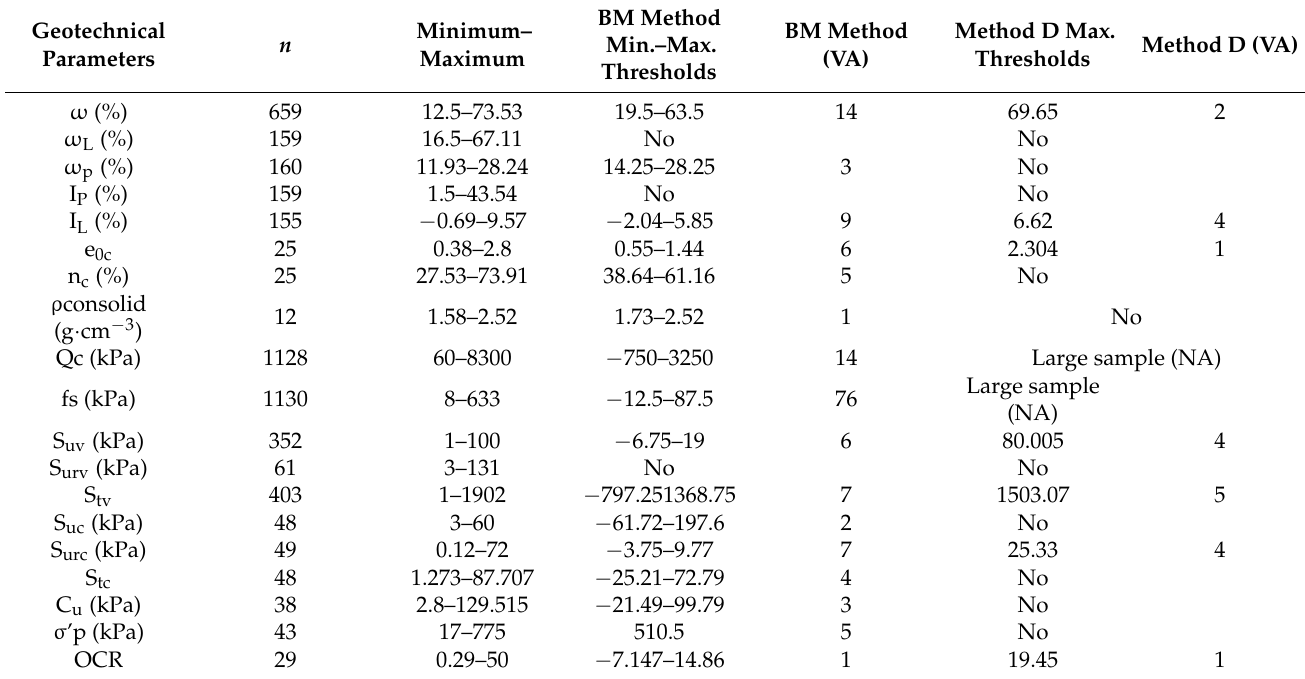
Table 2. Outliers and values detected by the box-and-whisker plot method and Doerffel